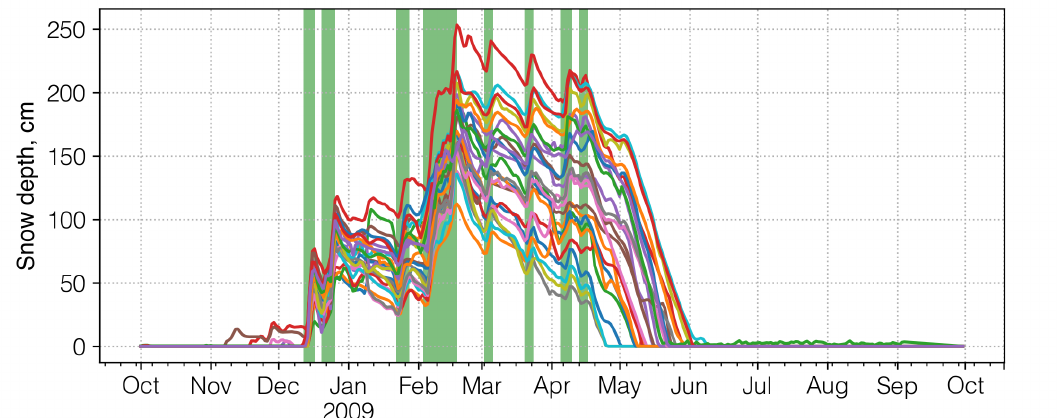
Figure 4. Snow accumulation events extracted using the accumulation detection algorithm, for Wolverton in water year 2009. Color lines are used to distinguish time series from different sensor nodes.